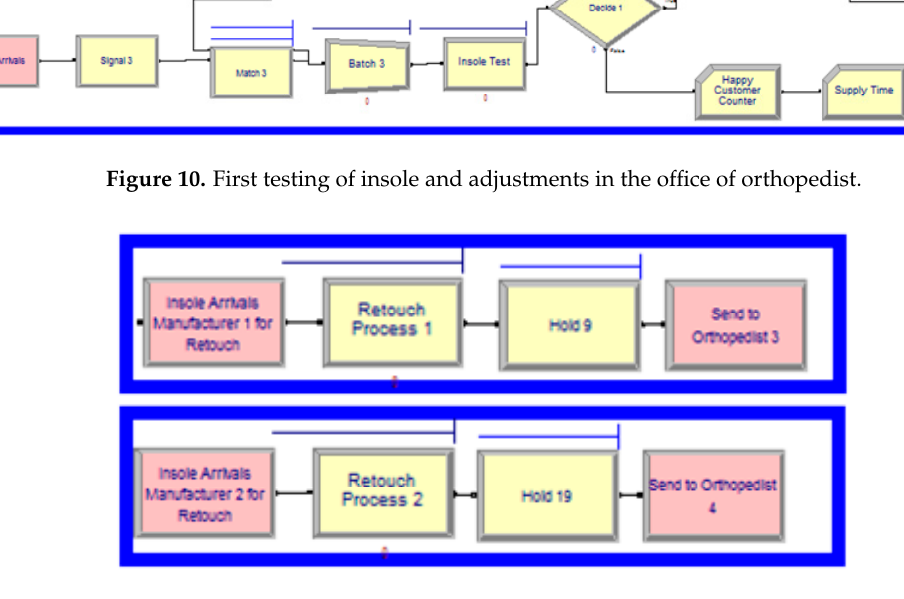
Figure 11. Re-manufacturing operations in the manufacturers if necessary. Logistics 2018 , 2 , 13